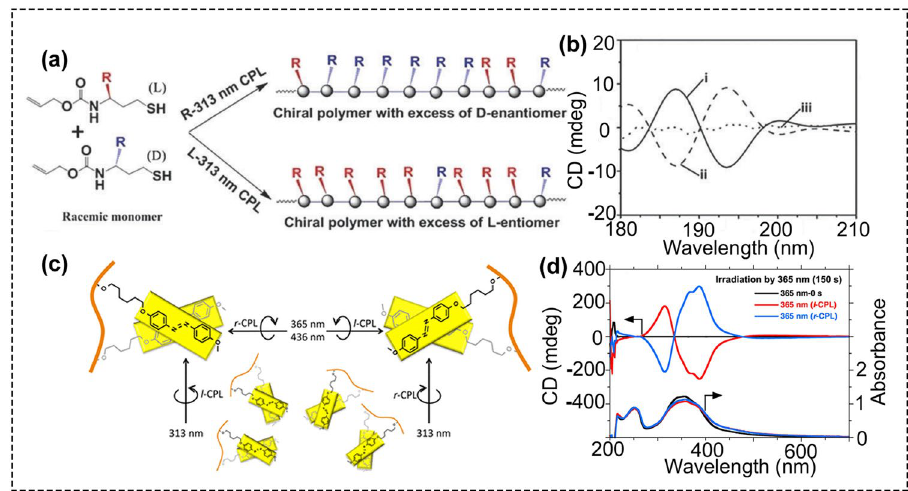
Fig. 2 a , b Circularly polarized light triggered enantioselective thiol–ene polymerization reaction. a Schematic illustration of the growing opti- cally active polymer from racemic monomers through the asymmetric thiol–ene polymerization process triggered by 313 nm CPL irradiation. b CD signals (irradiation for 90 min) of the specific rotation values of the final polymer obtained by irradiation with 313 nm (i) LCP, (ii) RCP, or (iii) normal UV light (reproduced with permission from Ref. [66]. Copyright 2017 the Royal Society of Chemistry). c , d CPL to regulate azobenzene supramolecular chirality. c Scheme of long- and short-axis-dependent twisted stack led by wavelength-dependent LCP and RCP light. d CD and UV–Vis spectra of PAzoMA 2 aggregates exposed to 365 nm LCP and RCP light for 150 s (reproduced with permission